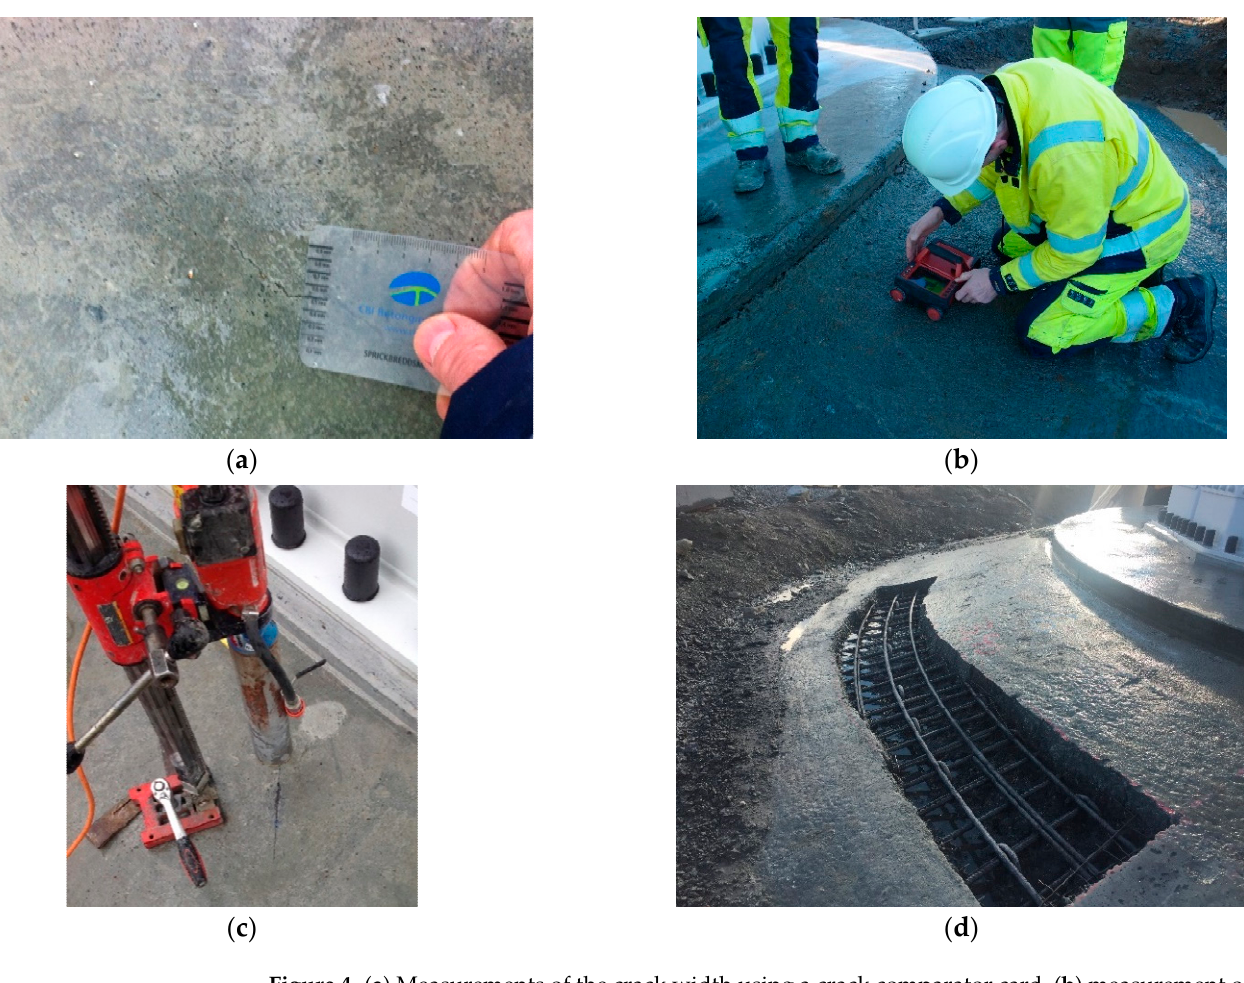
Figure 4. ( a ) Measurements of the crack width using a crack comparator card, ( b ) measurement of the concrete cover using a concrete scanner, ( c ) drilling of concrete cores from the foundations, and ( d ) after water jet removal of the top concrete layer.